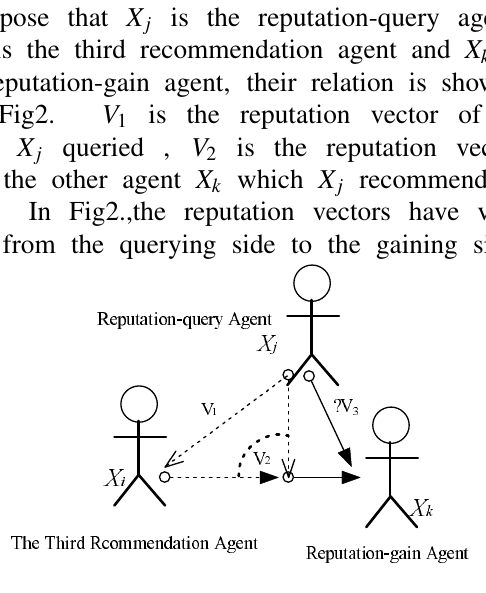
Fig. 2. The recommend relation of X i , X j and X